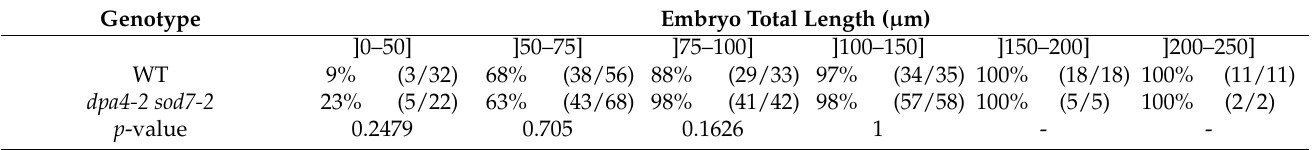
Table 2. Frequency of CLV3 expression in embryos depending on the embryo size and the